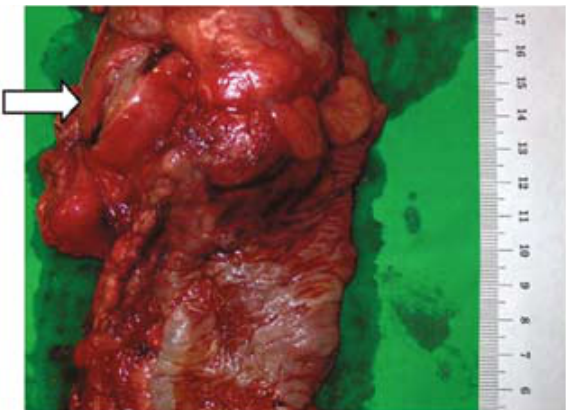
Fig. 2. The largest abscess after excision. This abscess was found adjacent to the ascending colon